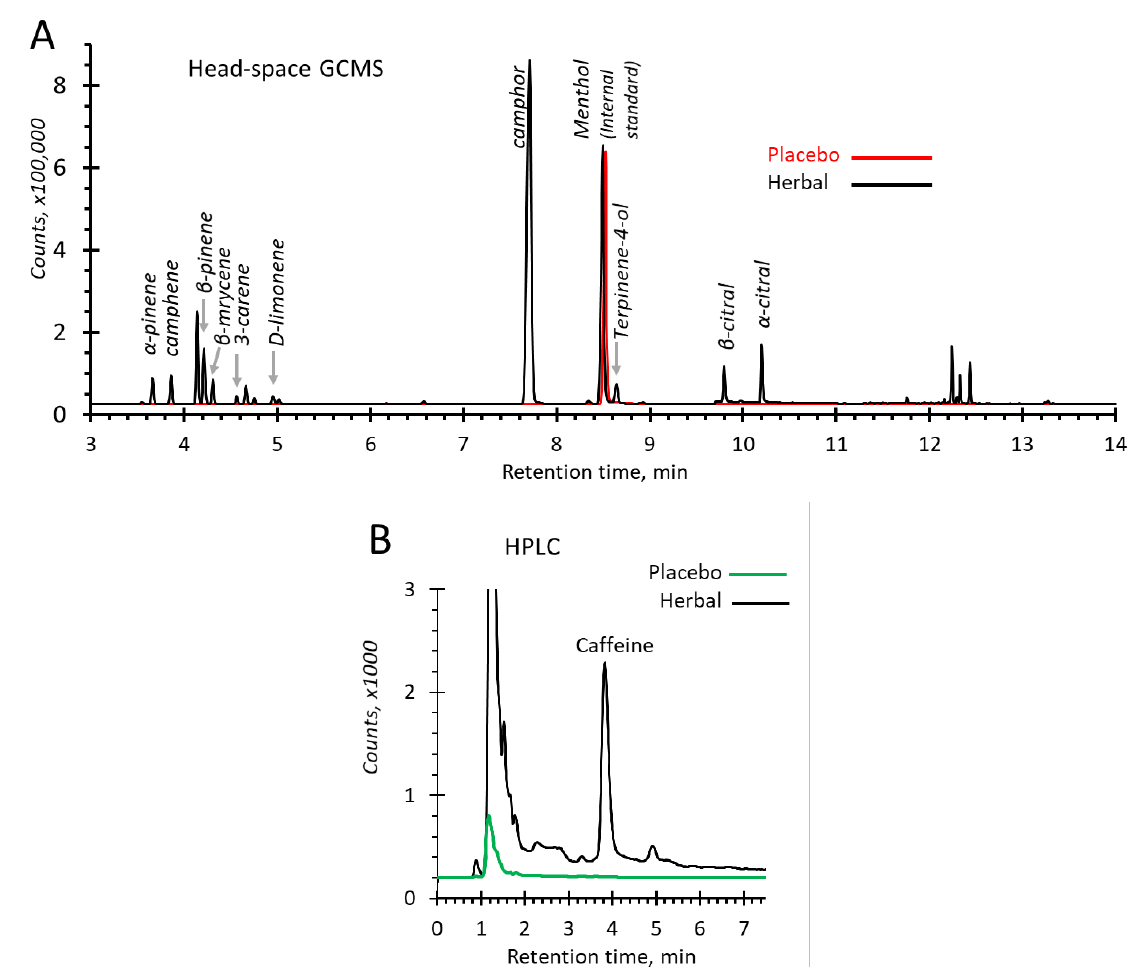
Figure 1. Chromatographic analyses of the chemical constituents in the placebo and the herbal emgels. ( A ) Headspace GC- MS (SIM) total ion chromatograms of 2 mg herbal emgel (black trace), and placebo emgel (red trace, displaced by 2 s), ( B ) HPLC chromatograms of 20 mg/mL of the herbal emgel (black trace), and the placebo emgel (green trace).